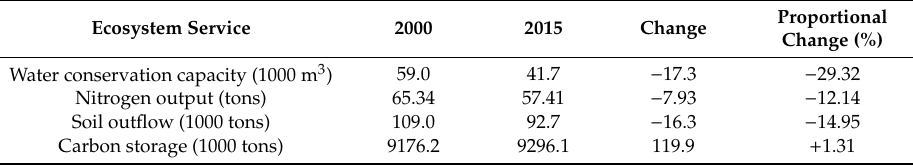
Table 2. Changes in ecosystem services over the period